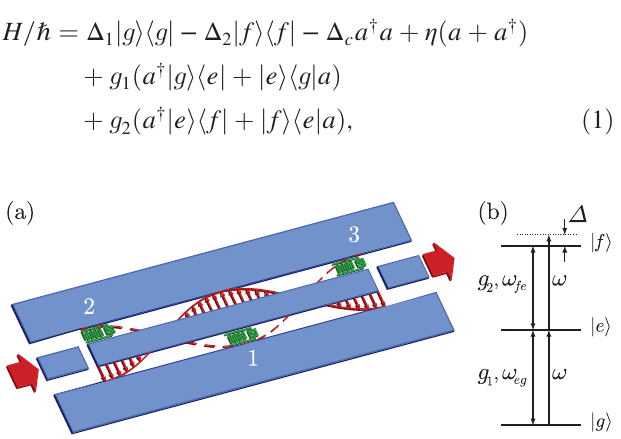
FIG. 1. (a) Scheme of the driven coplanar waveguide resonator (blue) coupled to up to three transmon artificial atoms (green). An external drive (red) is applied via the input capacitor, and the coherent transmission is detected via the output capacitor. (b) Level scheme of one artificial atom indicating the parameters of the Hamiltonian in Eq.